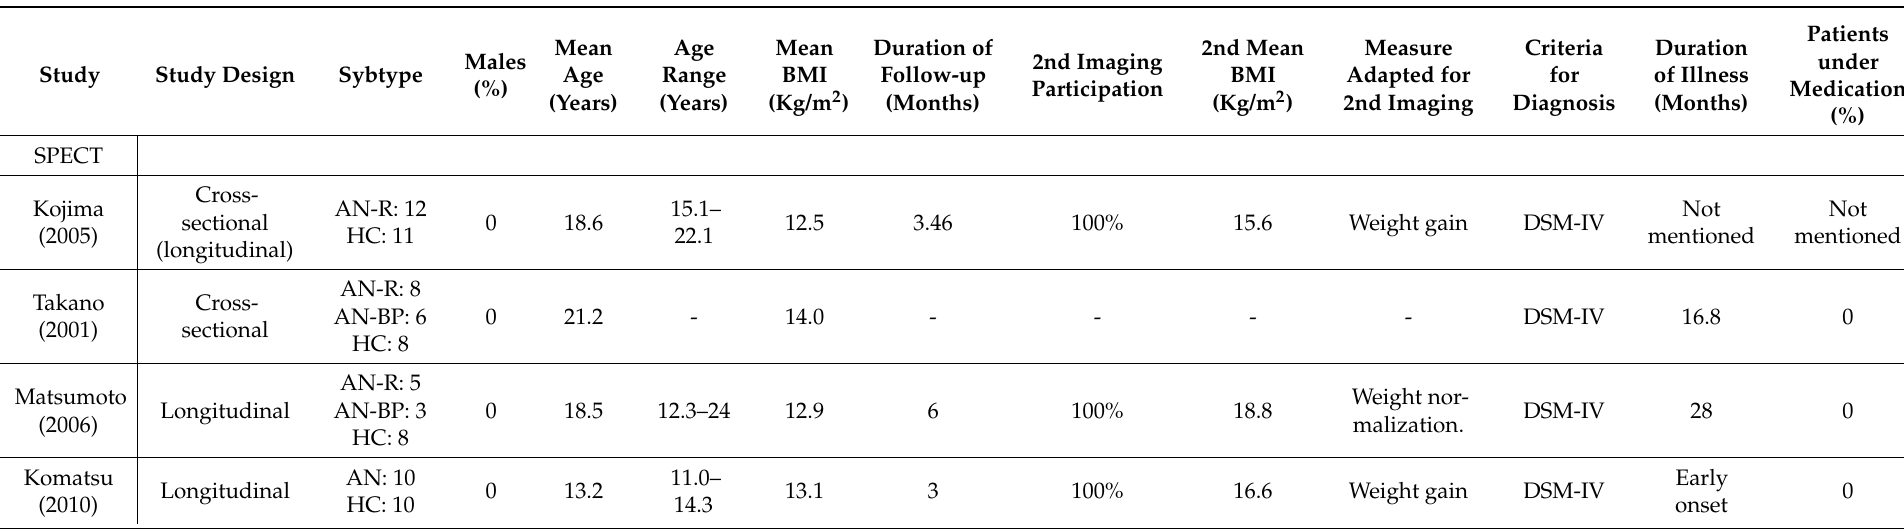
Table 3. Functional imaging studies—sample